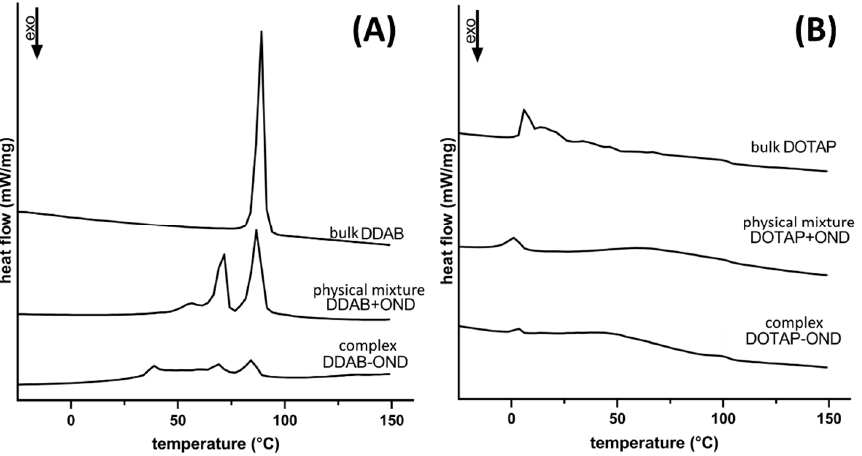
Figure 4. Differential scanning calorimetry of the bulk lipids, physical mixtures and complexes of ( A ) DDAB and ( B ) DOTAP. Thermograms were recorded from − 50 up to 150 °C at the heating rate 10 °C/min.